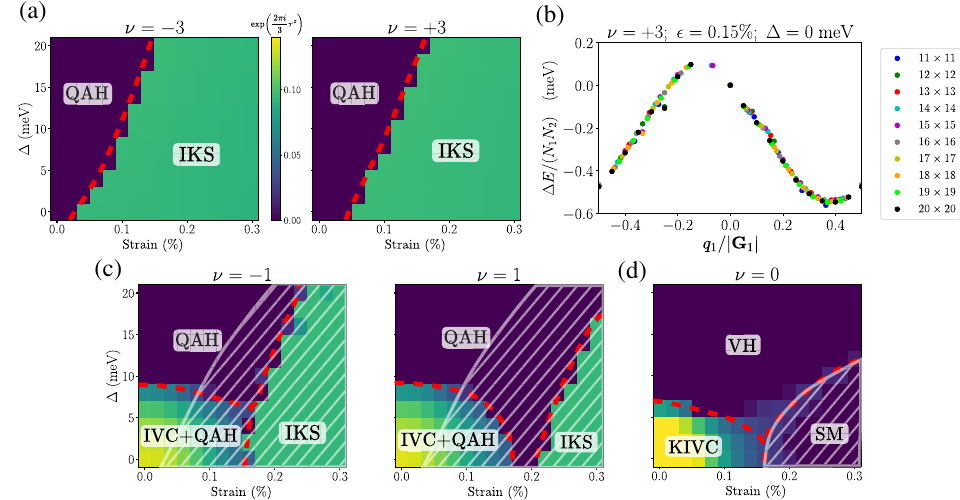
FIG. 6. (a) ν ¼ (cid:2) 3 strain-substrate HF phase diagram using the same parameters as Fig. 3 (enlarged view from Fig. 2). (b) Dispersion relation of the IKS state at filling ν ¼ þ 3 for different system sizes (with Δ ¼ 0 meV, ϵ ¼ 0 . 15% , and no NLT). Δ E is the energy of the IKS solution at a given wave vector q ˆ x compared to the energy of the translationally invariant ( q ¼ 0 ) QAH state. (c),(d) The same